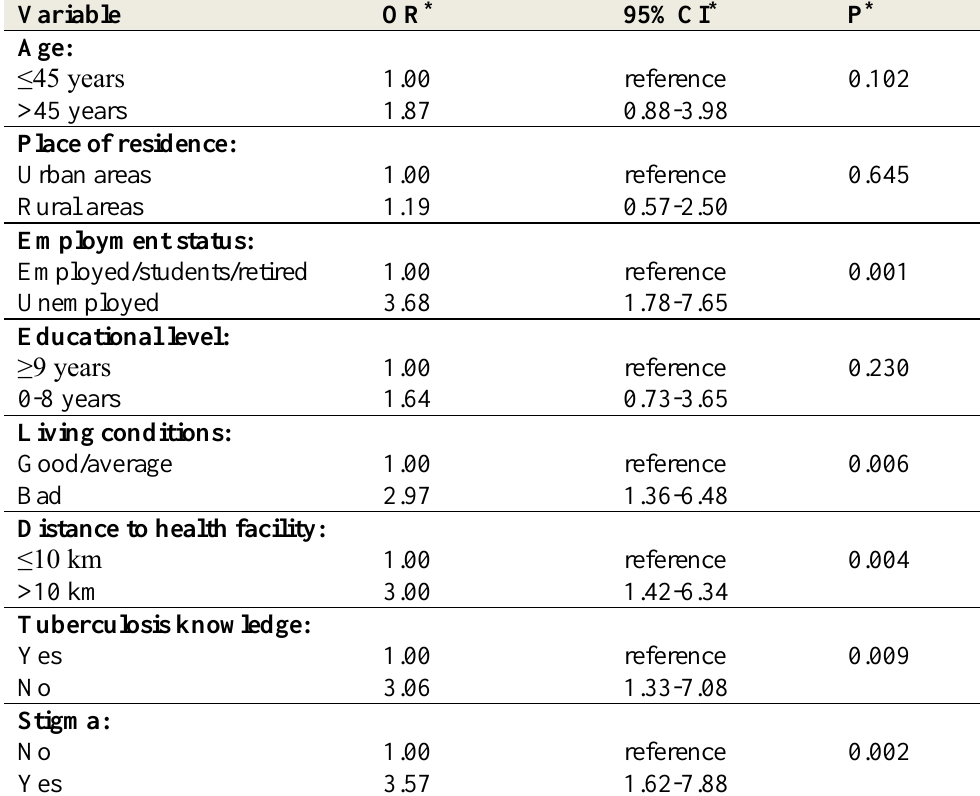
Table 3. Sex-differences in socioeconomic characteristics, knowledge and attitudes about tuberculosis, and access to health care among tuberculosis patients in Albania; multivariable- adjusted odds ratios from binary logistic regression Variable OR * 95%CI * P